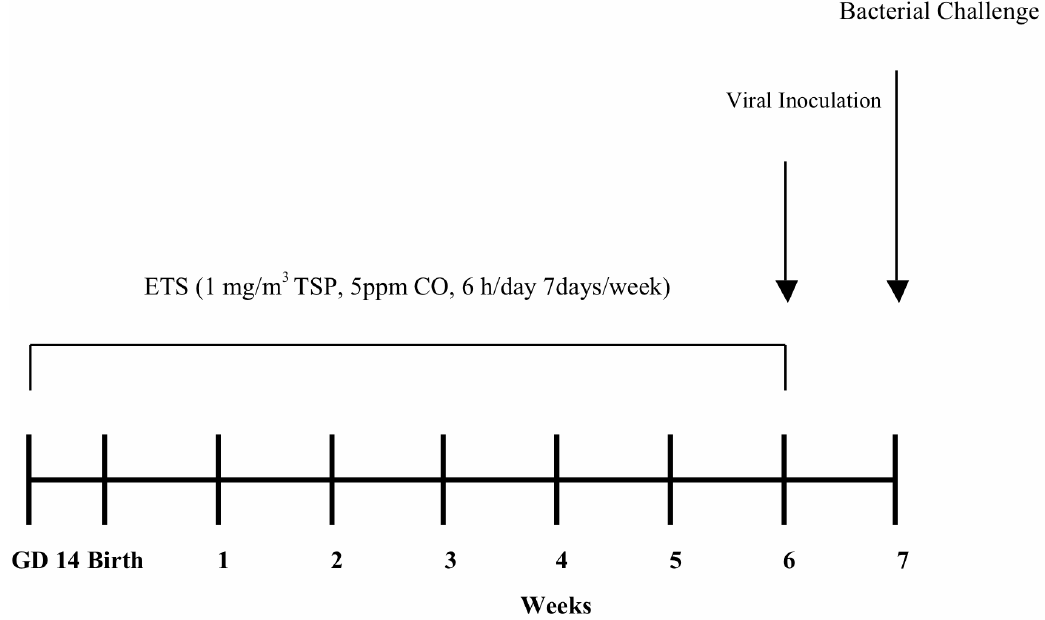
Figure 1. Experimental timeline. Balb/c moms began ETS exposure on gestation day 14. After birth on gestation day 21, moms and pups continued exposure. By three weeks of age, pups were weaned from their mother, while ETS exposure continued to 6 weeks of age followed by an intranasal viral infection (week 6) and an intranasal bacterial infection 1 week later (week 7). Mice were sacrificed 1-day post bacterial infection. Control animals were exposed to filtered